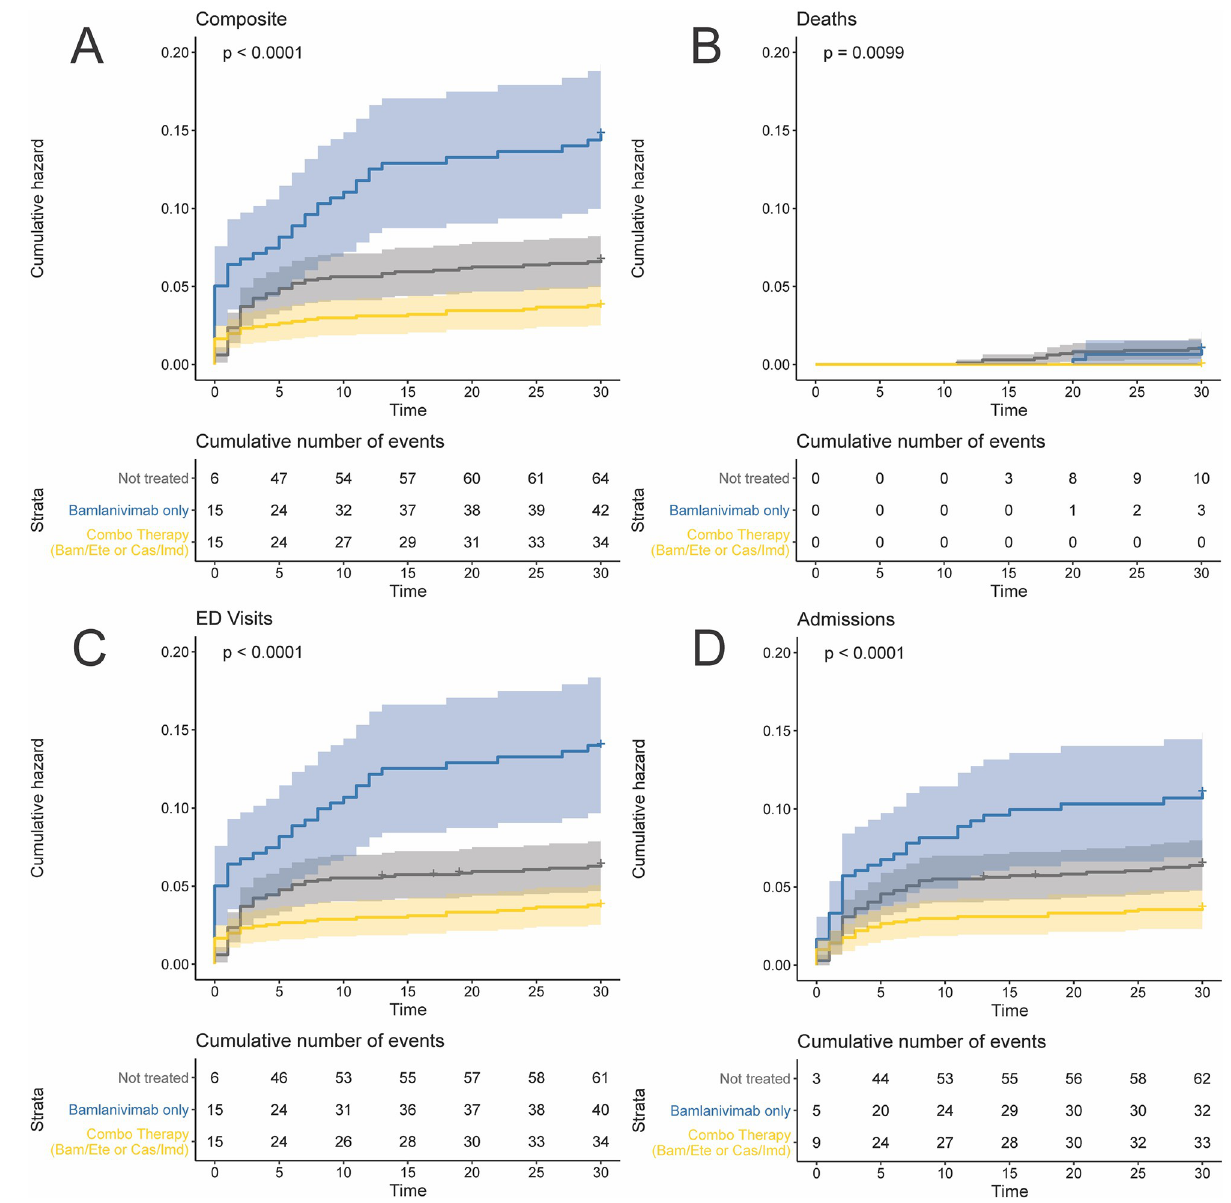
Fig 1. Unadjusted Kaplan-Meier Curves for 30-day Risk of (A) ED Visit, Hospital Admission, or Death; (B) Death Only; (C) ED Visit Only; (D) Hospital Admission Only Stratified by Treatment Status. Shading represents 95% confidence interval. Significant differences between curves are indicated with log-rank